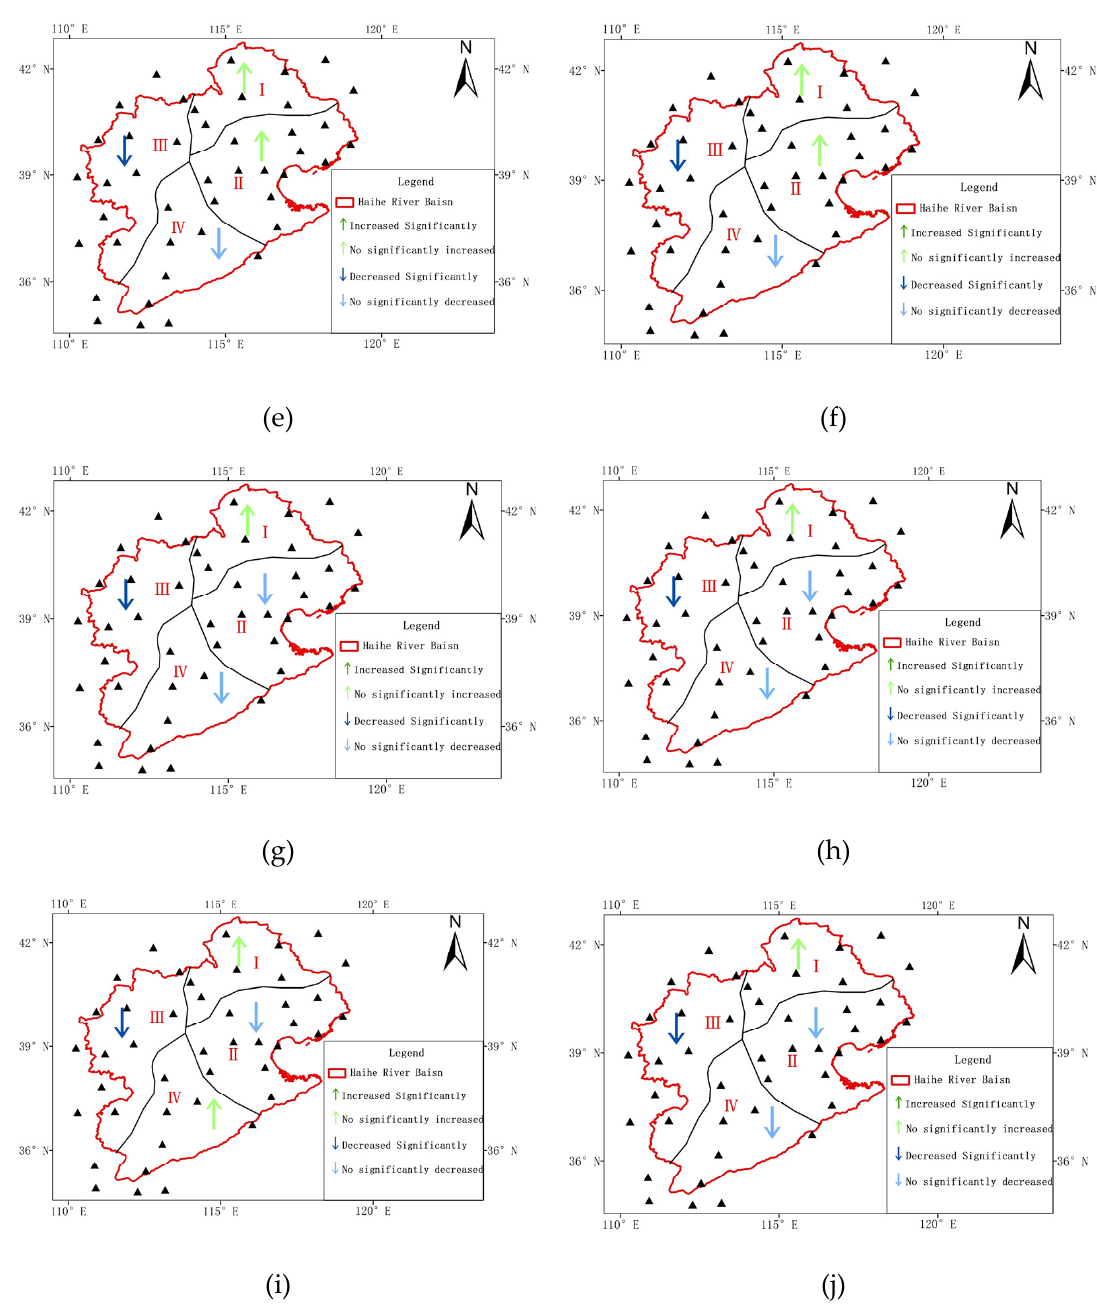
Figure 6. The Mann–Kendall (M–K) trend test results for the snowfall at the different levels in each zone in the Haihe River Basin ( a ) Average snowfall, ( b ) average snowfall days, ( c ) light snowfall, ( d ) light snowfall days, ( e ) moderate snowfall, ( f ) moderate snowfall days, ( g ) heavy snowfall, ( h ) heavy snowfall days, ( i ) snowstorm, ( j ) snowstorm days.